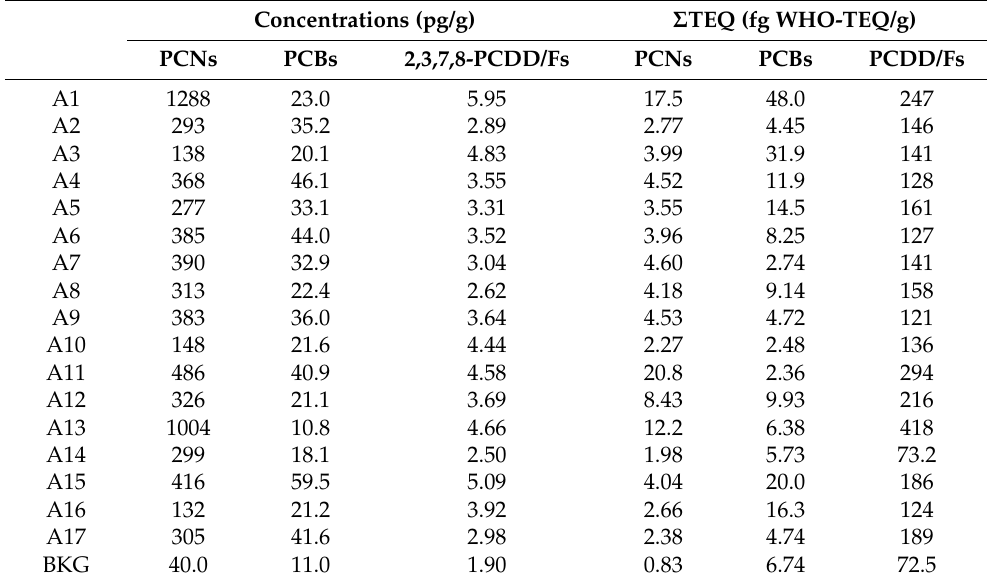
Table 1. Concentrations of PCDD/Fs, PCBs, and PCNs of the soil samples and background (BKG) site. Concentrations (pg/g) Σ TEQ (fg WHO-TEQ/g) PCNs PCBs 2,3,7,8-PCDD/Fs PCNs PCBs PCDD/Fs A1